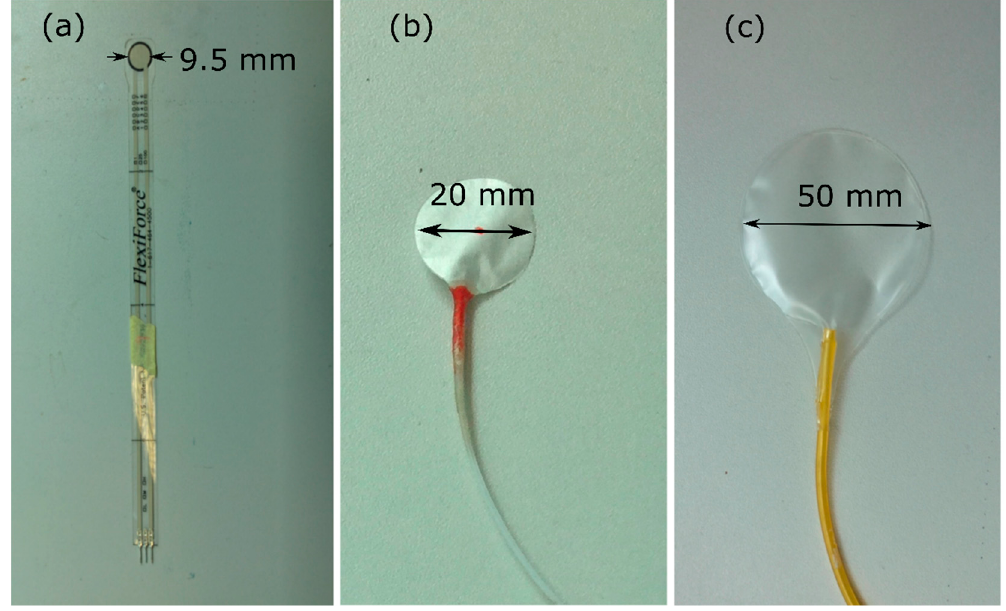
Figure 1. The sensors used for the evaluation ( a ) FlexiForce ® sensor ( b ) AMI air-pack sensor ( c ) PicoPress ® sensor.